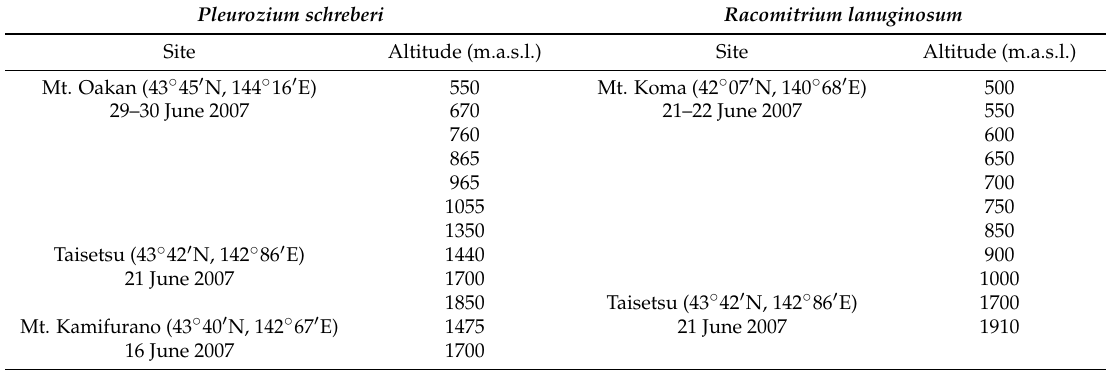
Table 4. Collection sites and time of collection for P. schreberi and R. lanuginosum from Hokkaido, northern Japan. m.a.s.l. = meters above sea